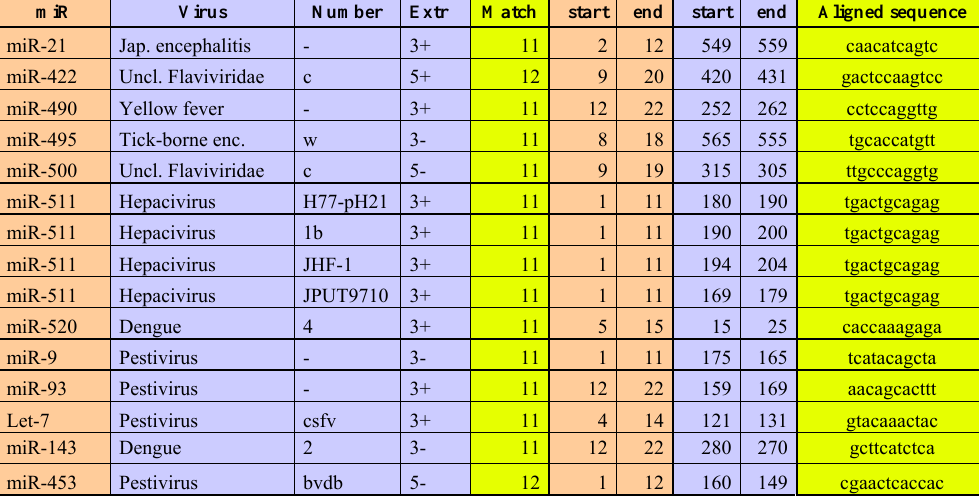
Table 2. Some best perfect matches ≥ 11 between human miRs and 8